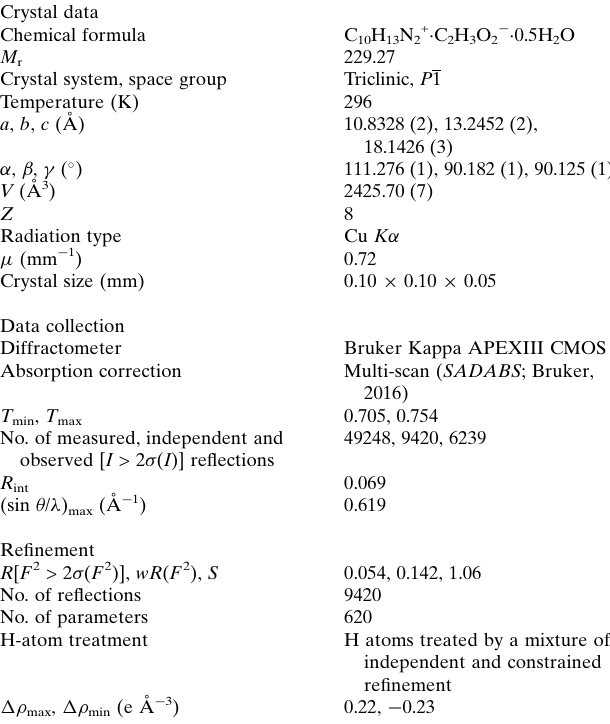
Table 2 Experimental details. Crystal data Chemical